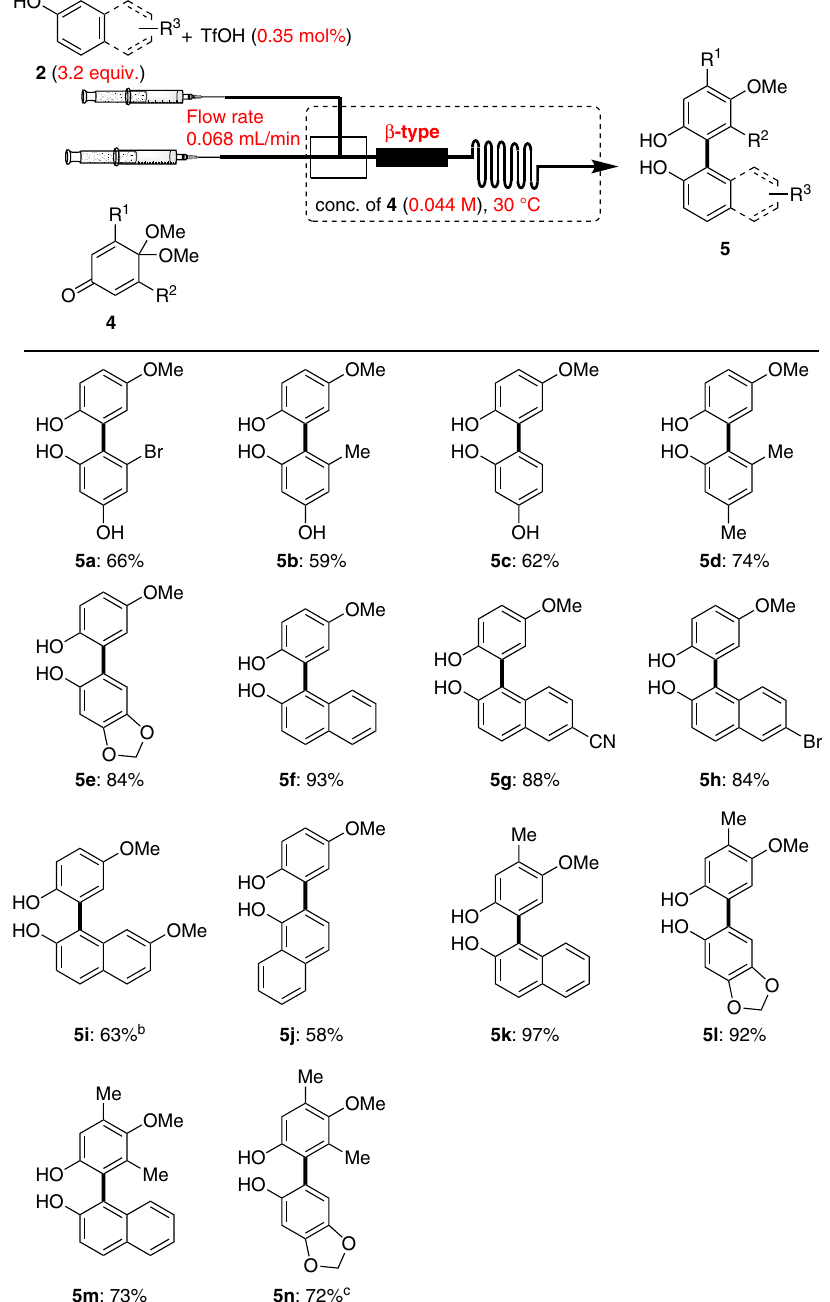
Fig. 3 Substrate scope of cross-coupling using QMAs 4 and arenols 2 a . Yields are those of isolated 5 . a Reaction conditions: 4 (0.065 mmol), 2 (3.2 equiv.), and TfOH (0.35 mol%) in degassed dry toluene/AcOEt (conc. of 4 , 0.044 M, 10/1), micro mixer: β -type, fl ow rate: 0.068 mL/min, at 30 °C. b Flow rate: 0.055mL/min, at 35 °C. c TfOH (0.5 mol%), fl ow rate: 0.048 mL/min, at 35